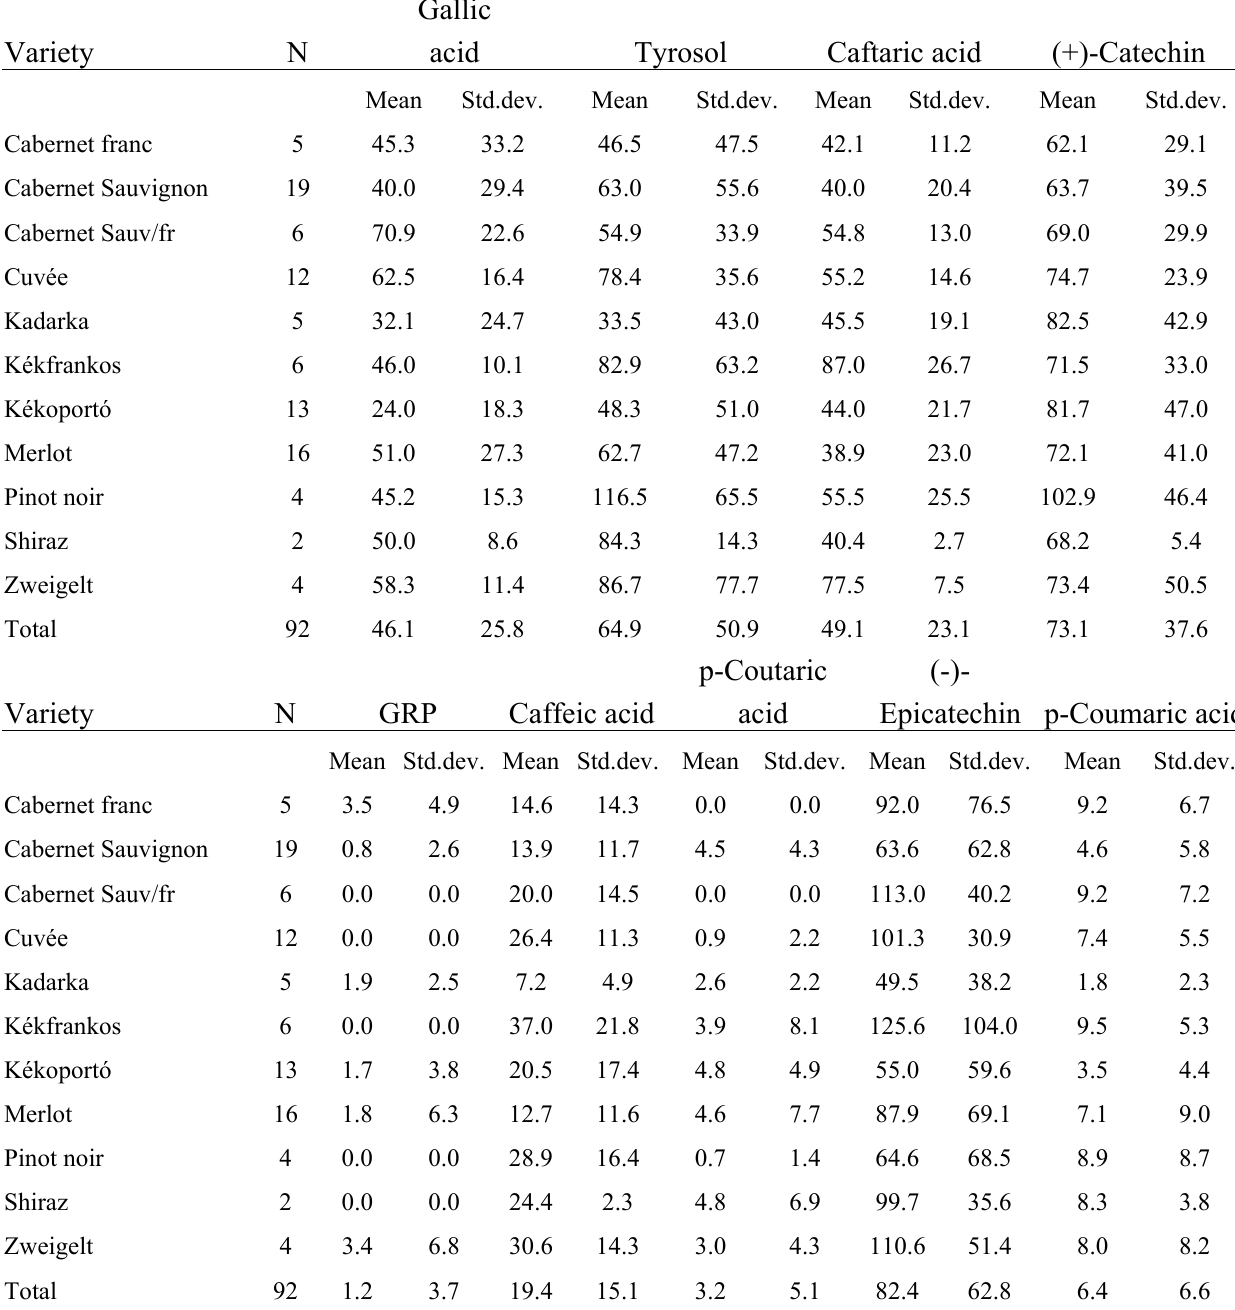
Table 1. Polyphenolic composition [mg/L] of Hungarian wines; data represent means of two independent